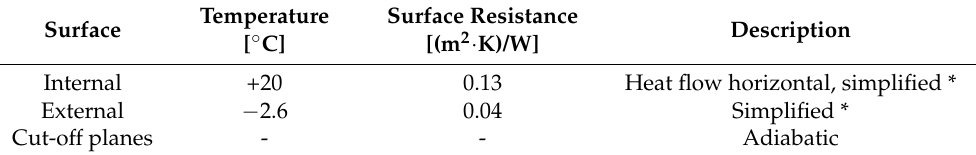
Table 4. Boundary conditions adopted in